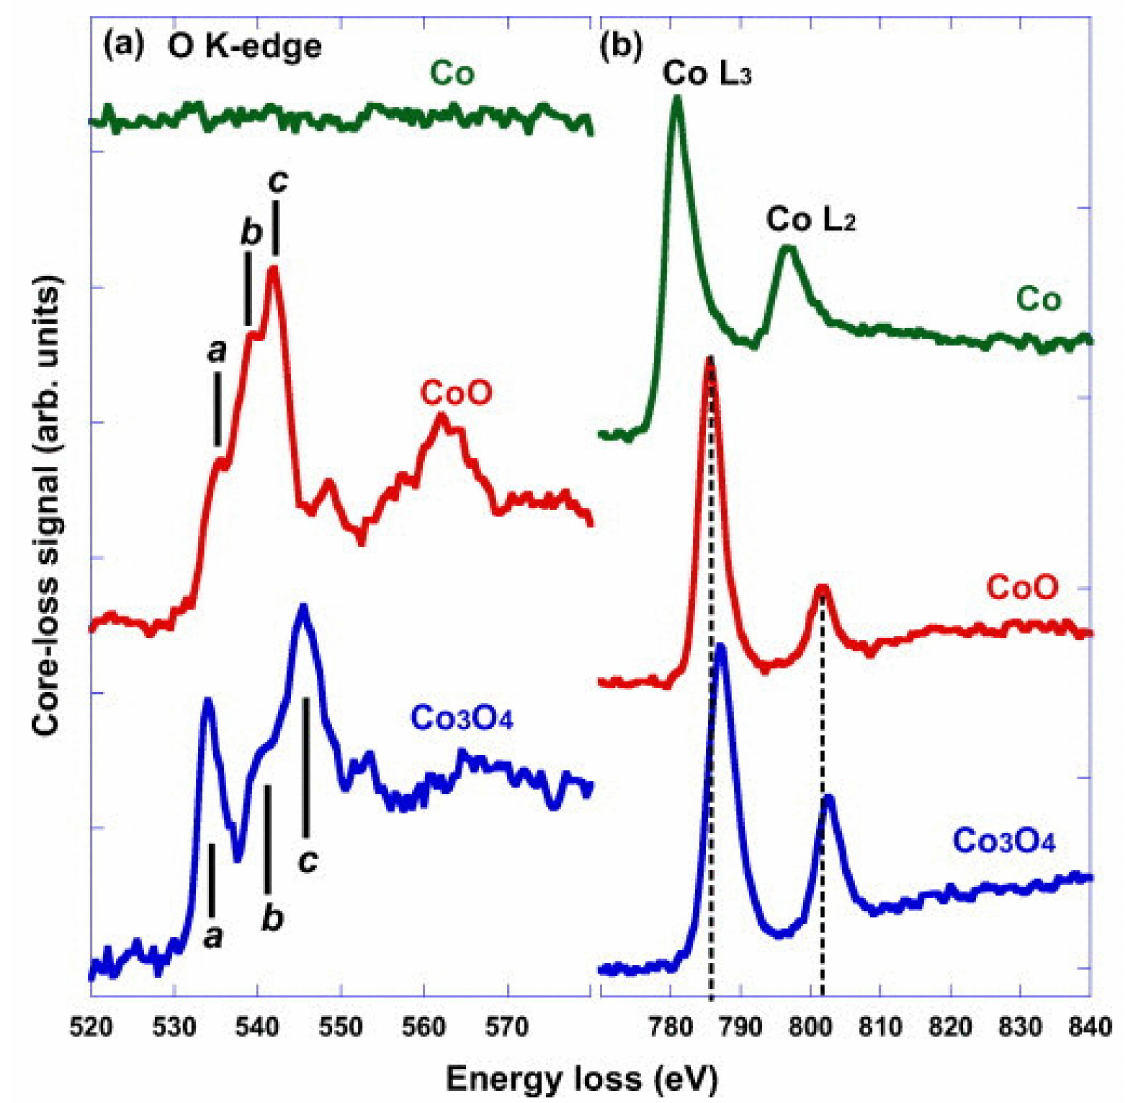
Figure 32. Comparison of ( a ) O K-edges and ( b ) Co-L 2,3 edges of metallic Co, CoO, and Co 3 O 4 [237]. Reprinted from in situ electron energy loss spectroscopy study of metallic Co and Co oxides, Zhao, Y., Feltes, T.E., Regalbuto, J.R., Meyer, R.J.,